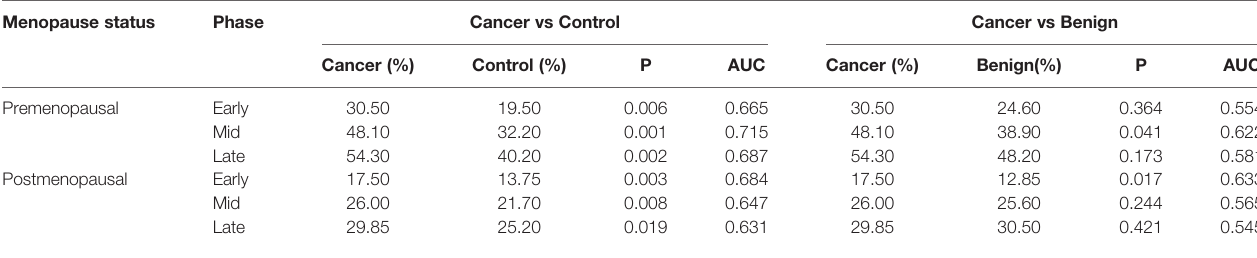
TABLE 4 | Comparison of BPE V and its AUC among cancer vs control and cancer vs benign. Menopause